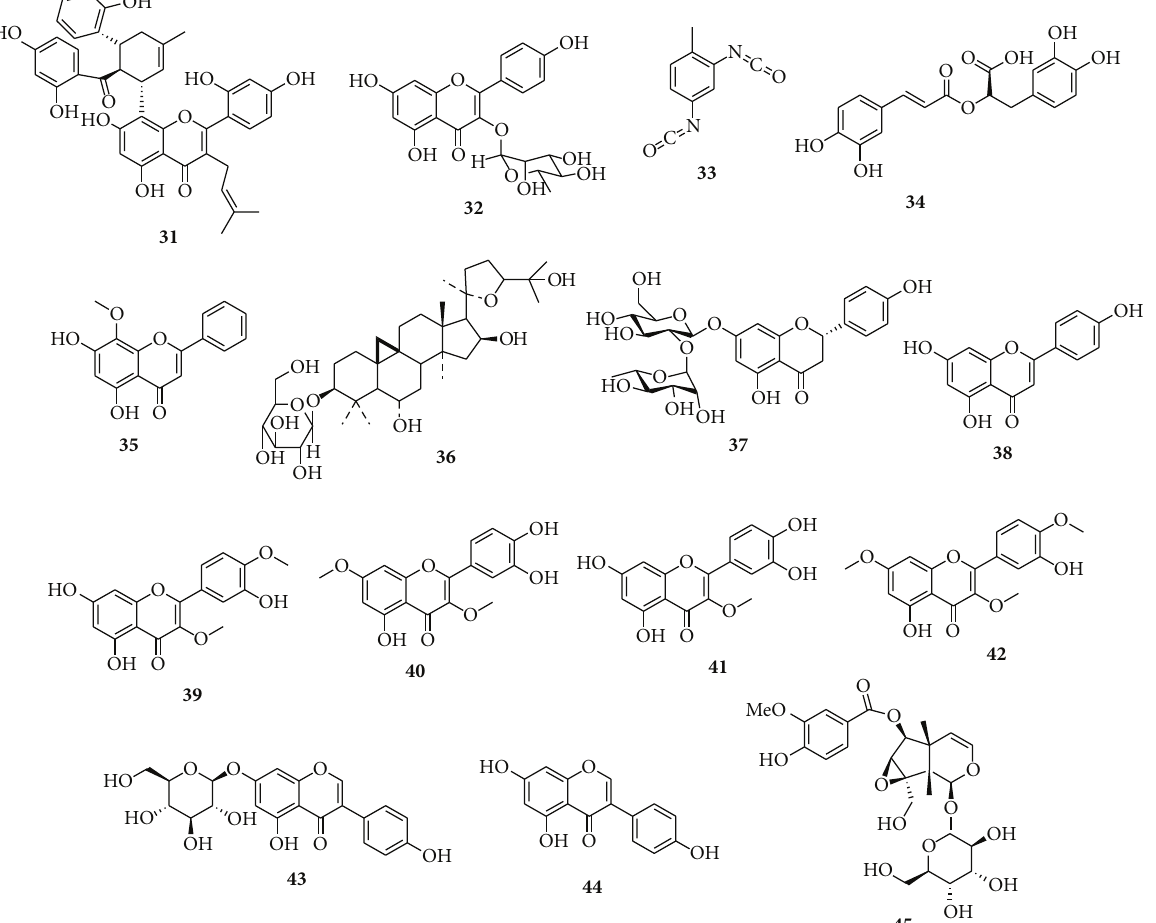
Figure 1: Natural products ( 1 – 45 ) from plants with effects in inflammatory lung